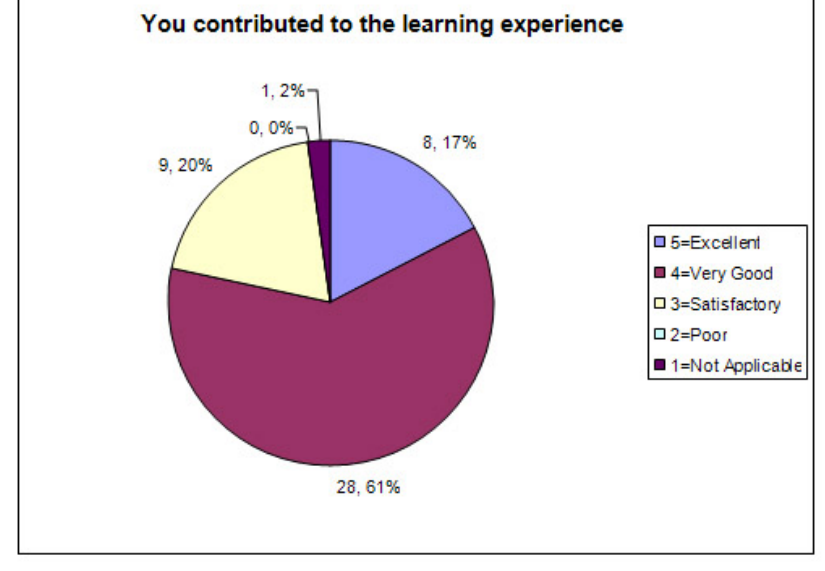
Figure 12. Mobile learning outcomes survey (See short answers